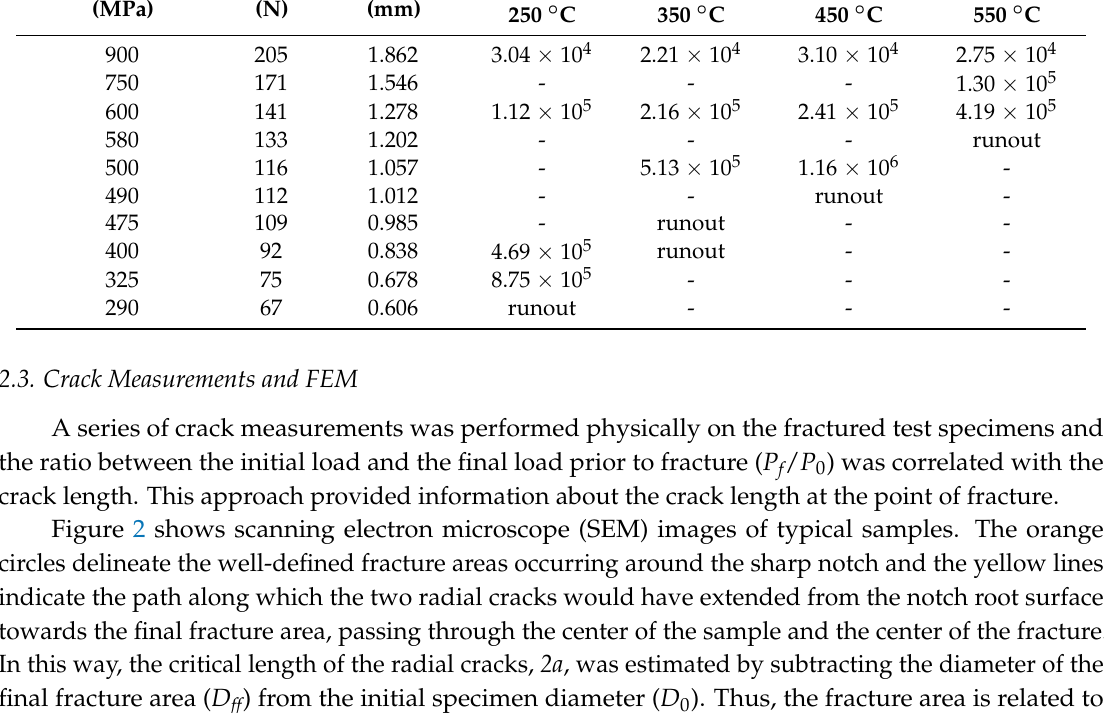
Table 2. Fatigue life measured at various stress levels with different tempering temperatures. Stress Amplitude